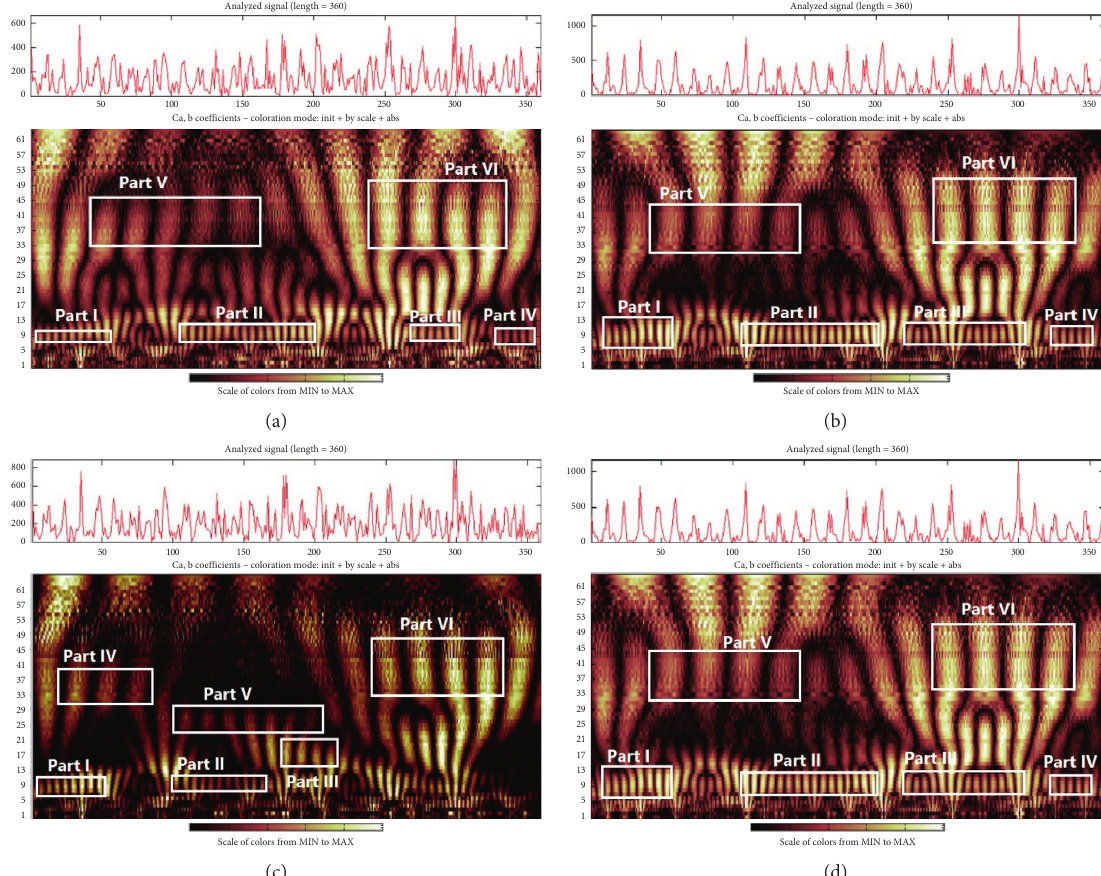
Figure 4: Continuous wavelet transform results for monthly rainfall: (a) for Badulla; (b) for Ledgerwatte Estate; (c) for Lower Spring Valley; (d) For